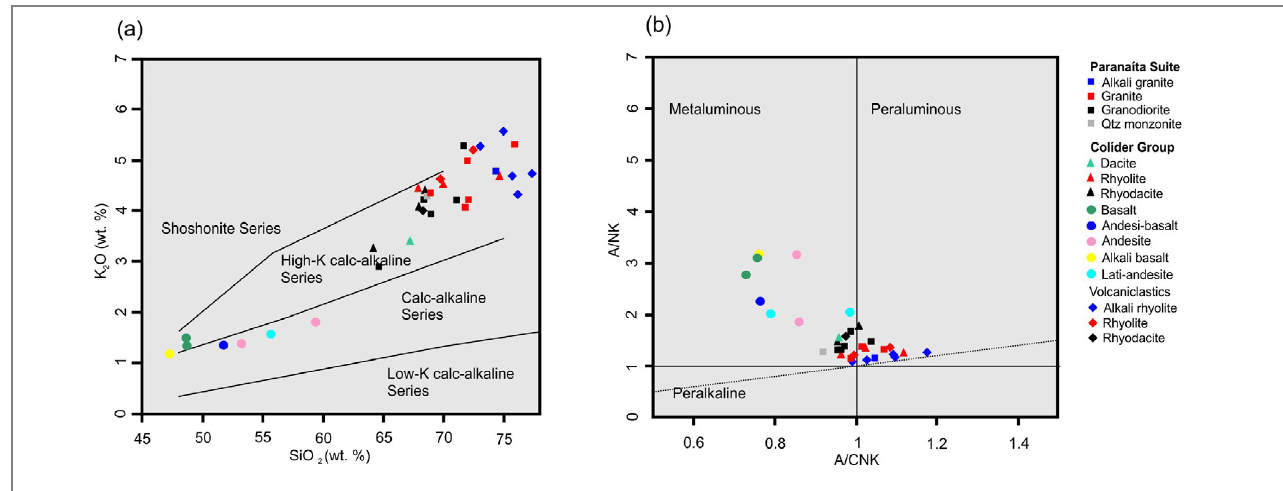
FIGURE 4 - SiO versus K O diagram of Peccerillo and Taylor (1976); and (b) Alumina saturation index Al 2 2 CaO+Na O+K O (A/CNK) diagram of Maniar and Piccoli 2 2